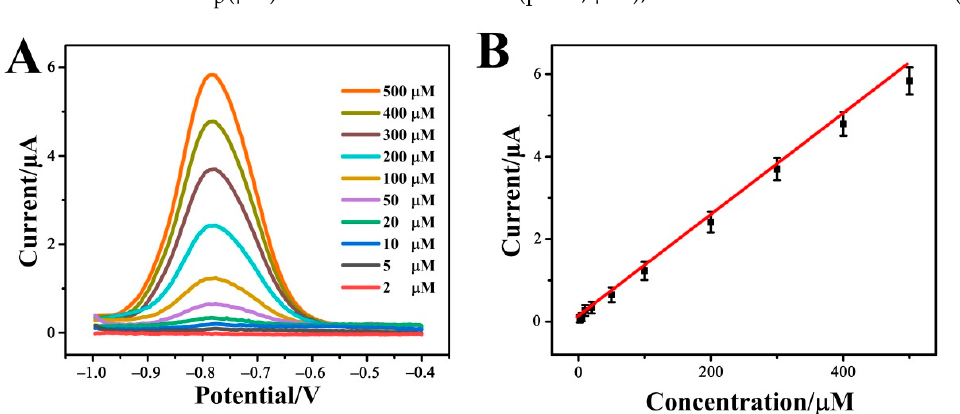
Figure 6. ( A ) DPV response curves and ( B ) linear relationship between DVP peak current and p-NP concentration of the Cr-MOF/GCE electrochemical sensor in 0.1 M phosphate buffer solution (pH = 7.0) containing different concentrations of p-NP from 2 to 500 μ M.